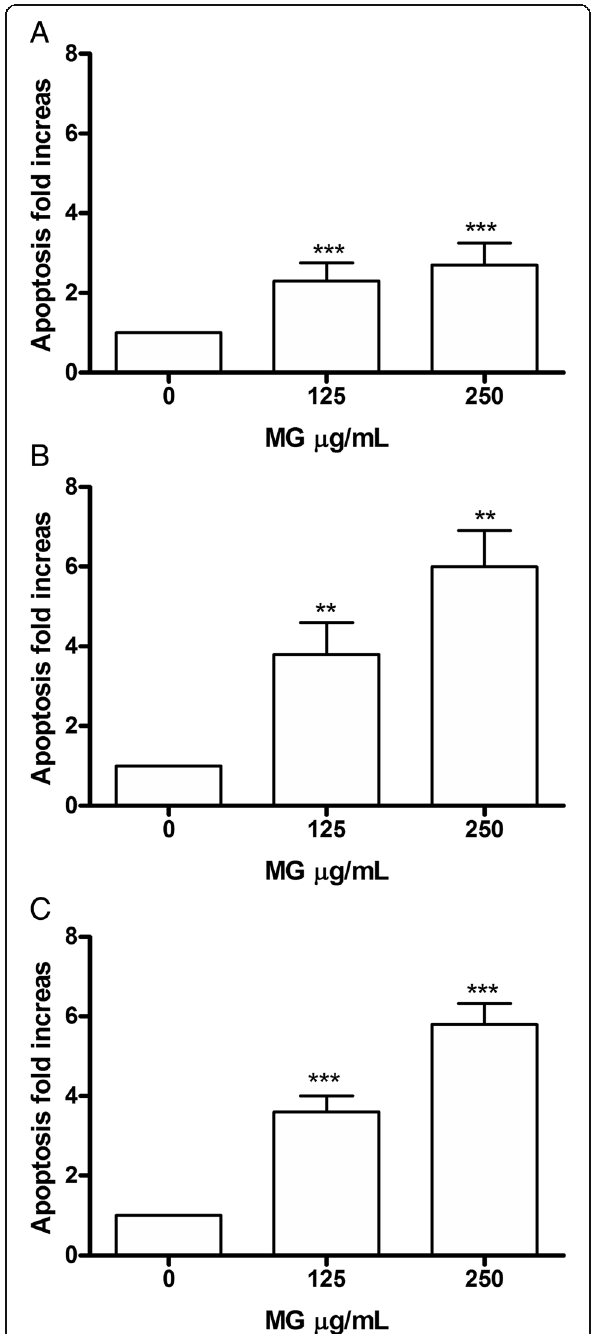
Fig. 2 Increase in apoptotic Jurkat cell fraction after MG treatment. Apoptosis was evaluated at 24 h ( a ), 48 h ( b ) and 72 h ( c ), as reported in Methods section. Each bar represents means ± SEM of five independent experiments. Data were analysed using repeated ANOVA followed by Bonferroni post-test. ** p < 0.01 vs control; *** p